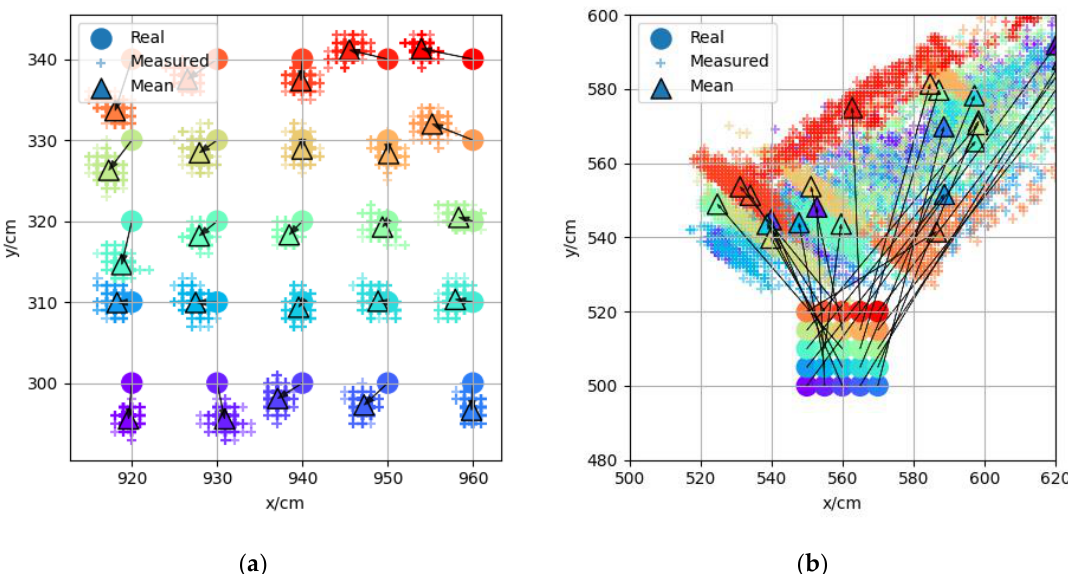
Figure 8. ( a ) Measuring point group (920,300) in the LOS scene. ( b ) Measuring point group (550,500) in the NLOS scene.